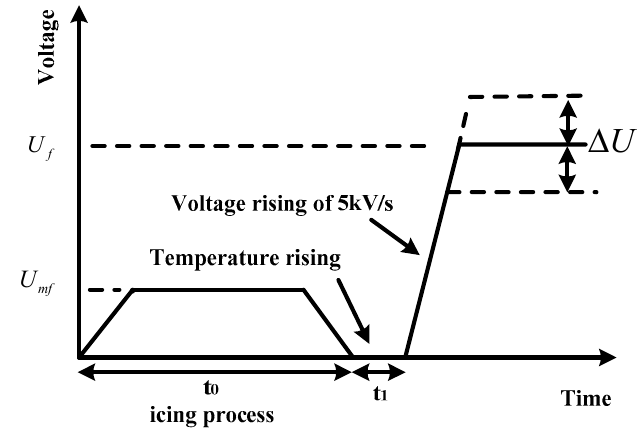
Figure 4. Sequence of the icing regime test procedure [18].